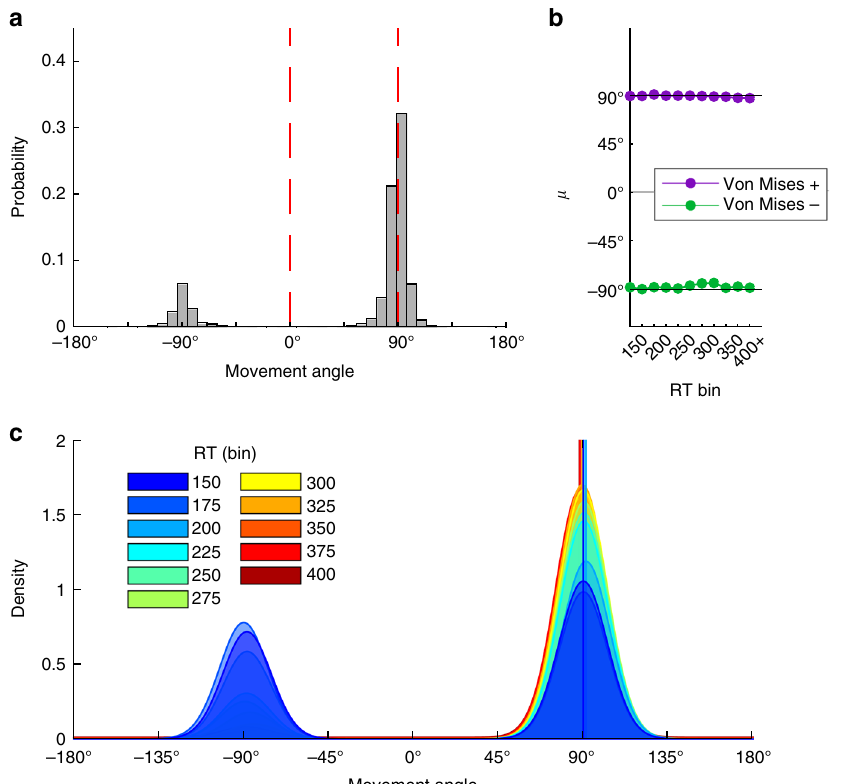
Fig. 7 The 2-target FORCED task full data distribution and model fi ts. a Full distribution of movement angles across all RTs in the 2-target variant of the FORCED task. b Fitted mean parameters from the “ Free- µ ” mixture model (starting at the 150 ms bin) for directed reaches with a correct sign (Von Mises + , purple) and a fl ipped sign (Von Mises − , green). See Methods for model details. c PDFs of model fi ts in each RT bin (in